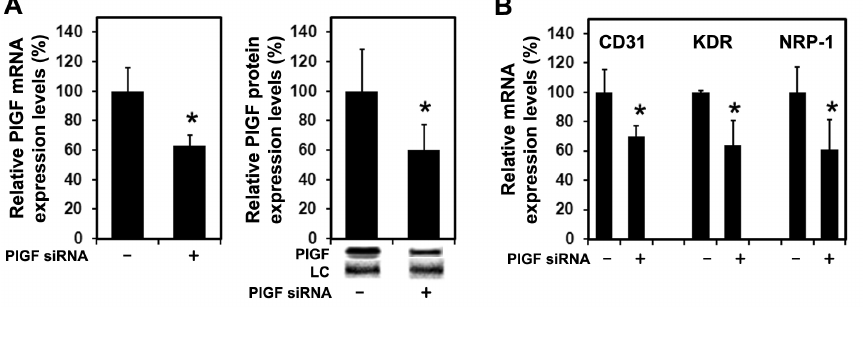
Figure 4. Stromal PlGF blockade reduces angiogenesis-related factors ( A ) Treatment of PC-3 xenografts with siRNA targeting murine PlGF reduces expression of intratumoral murine PlGF mRNA (left panel) and protein (right panel) compared to controls. * significantly different from control, p < 0.05; ( B ) Tumoral expression of murine CD31, KDR and NRP1 mRNA was significantly reduced after PlGF siRNA treatment compared to control tumors on day 24. * significantly different from control, p <